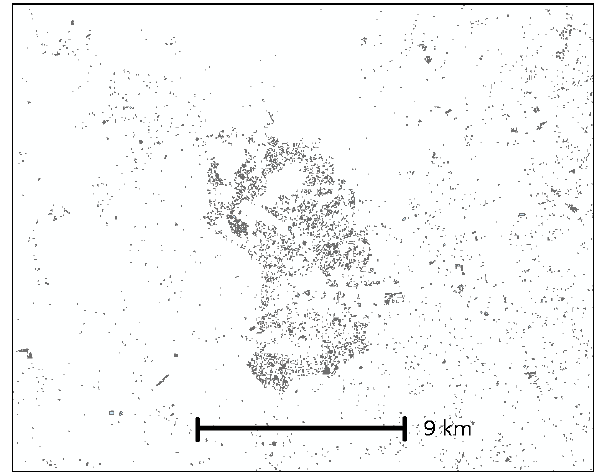
Figure 6. Difference-Layer with afterwards added small objects